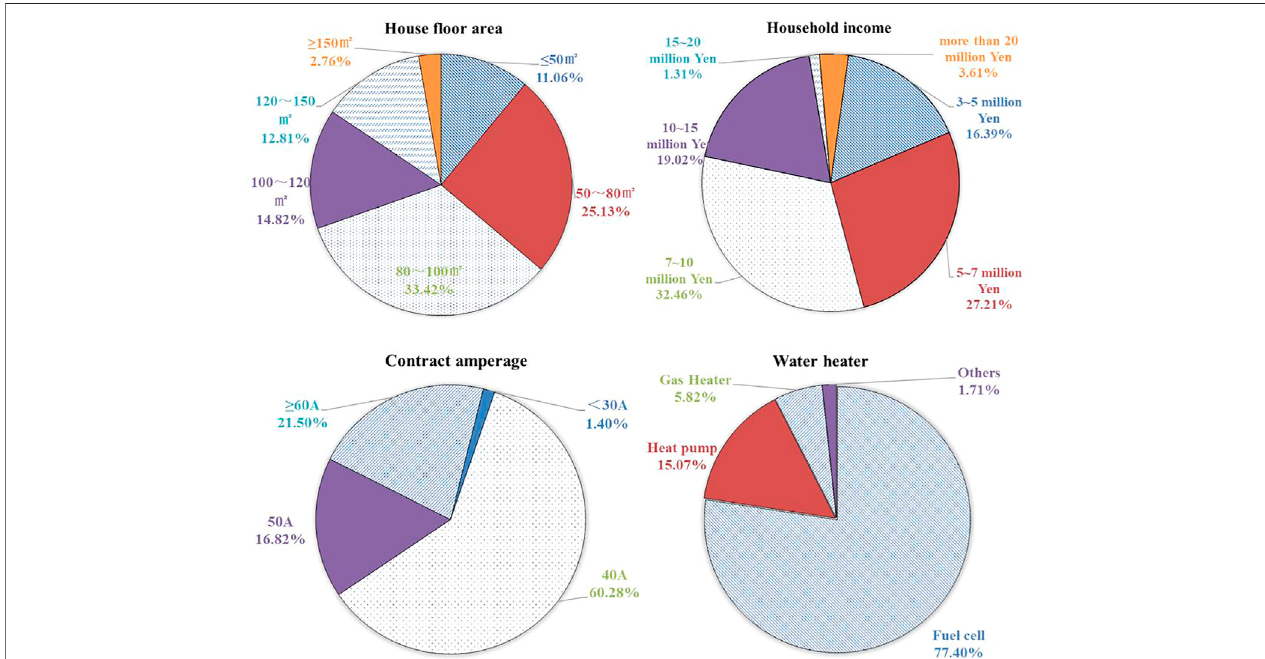
FIGURE 5 | Basic information of interviewed households in the zero-carbon district demonstration project.